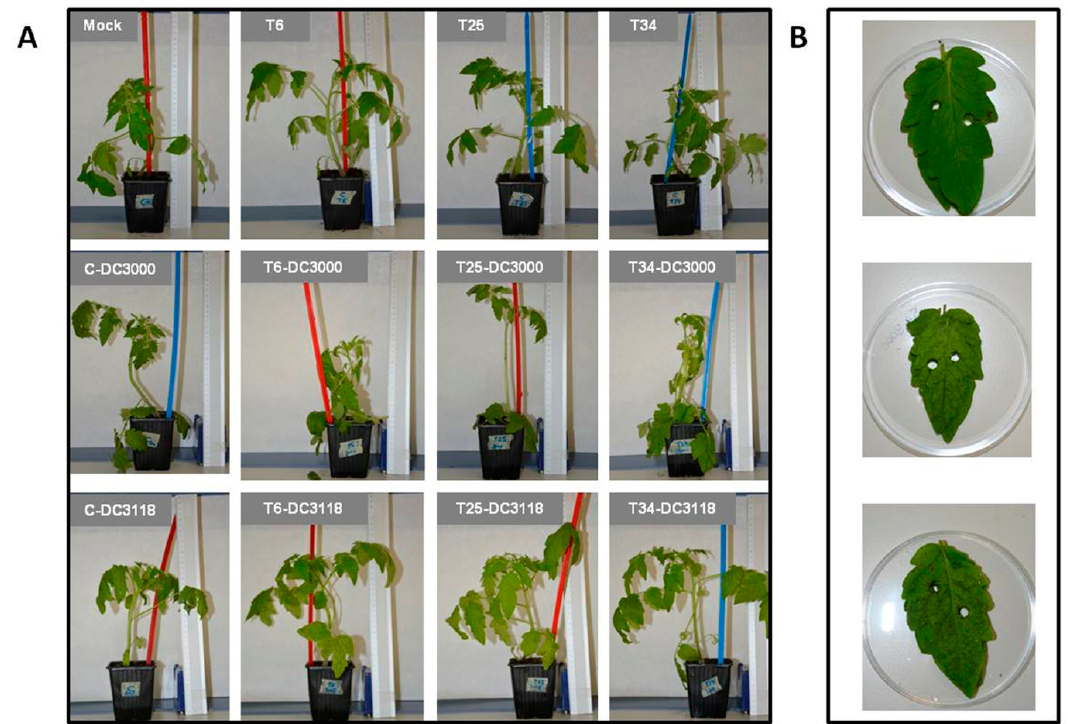
Figure 1. Experimental setup of tomato plants and their interaction with Trichoderma strains and P. syringae strains. ( A ) Four-week-old plants dip-inoculated with Pst strains at 72 hpi (DC3000, center row and DC3118, bottom row) and control plants (top row). ( B ) Disease symptoms on a pool of 8 leaflets used for counting bacterial populations (Mock, top; C-DC3000, center; and C-DC3118, bottom).